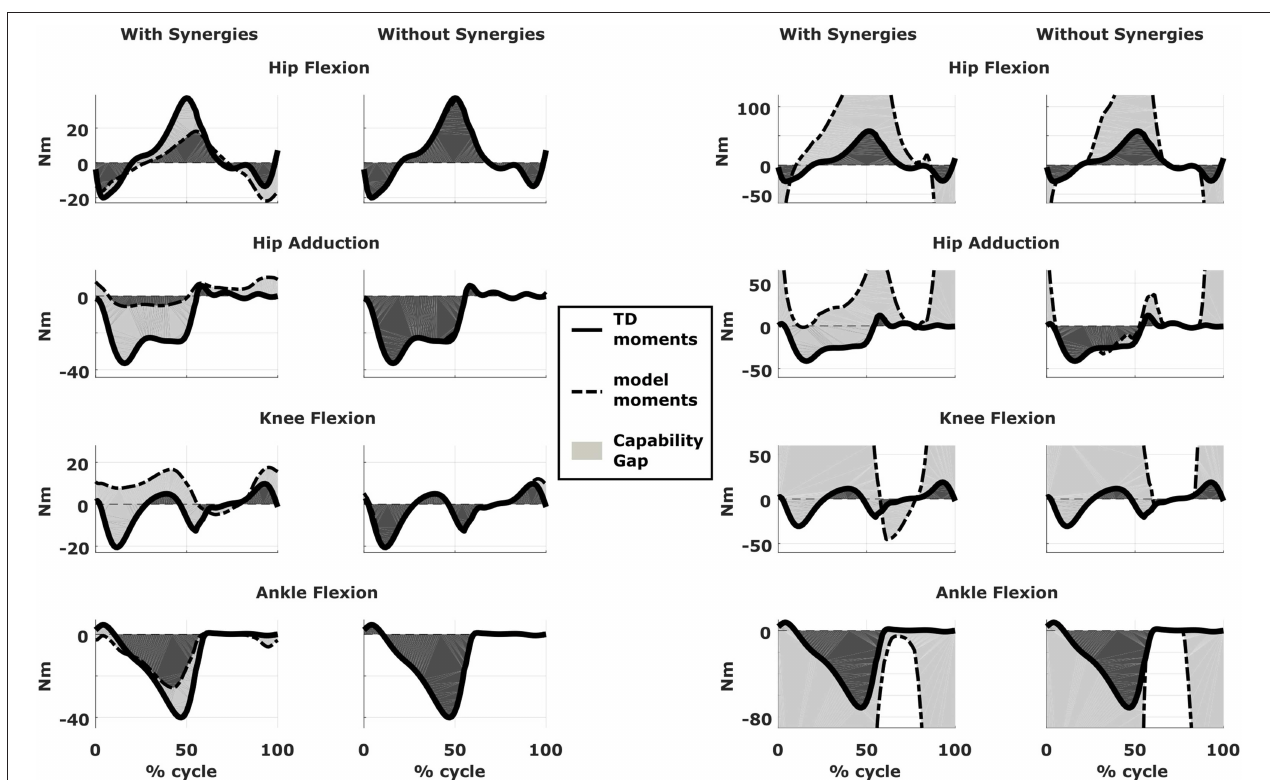
FIGURE 5 | Effect of motor control on capability gap. Capability gap computed relative to the pre-operative condition for the right legs of both patients (on the left side is Patient 1, on the right is Patient 2). The continuous black lines represent the joint moments required for the model to reach the desired kinematics [i.e., typically developed (TD) gait cycle]. When synergies are taken into account the muscle activations are computed from the pre-operative weight vectors, which define the muscle coordination specific to the impairment; when synergies are not taken into account muscles are activated selectively, thus simulating an unimpaired motor